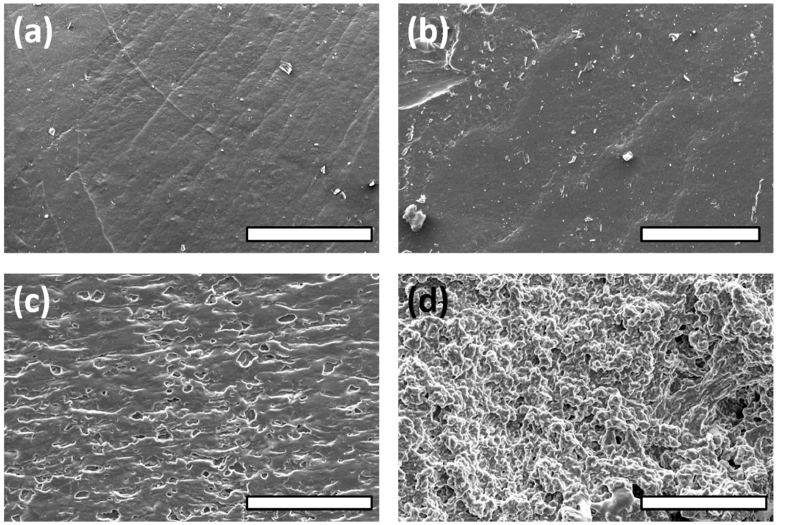
Figure 5. Photographs of elastomer sheets’ surfaces by FE-SEM observations: ( a ) PGS4; ( b ) PGS5; ( c ) PGS6; ( d ) PGS7. Scale bars = 400 µm.